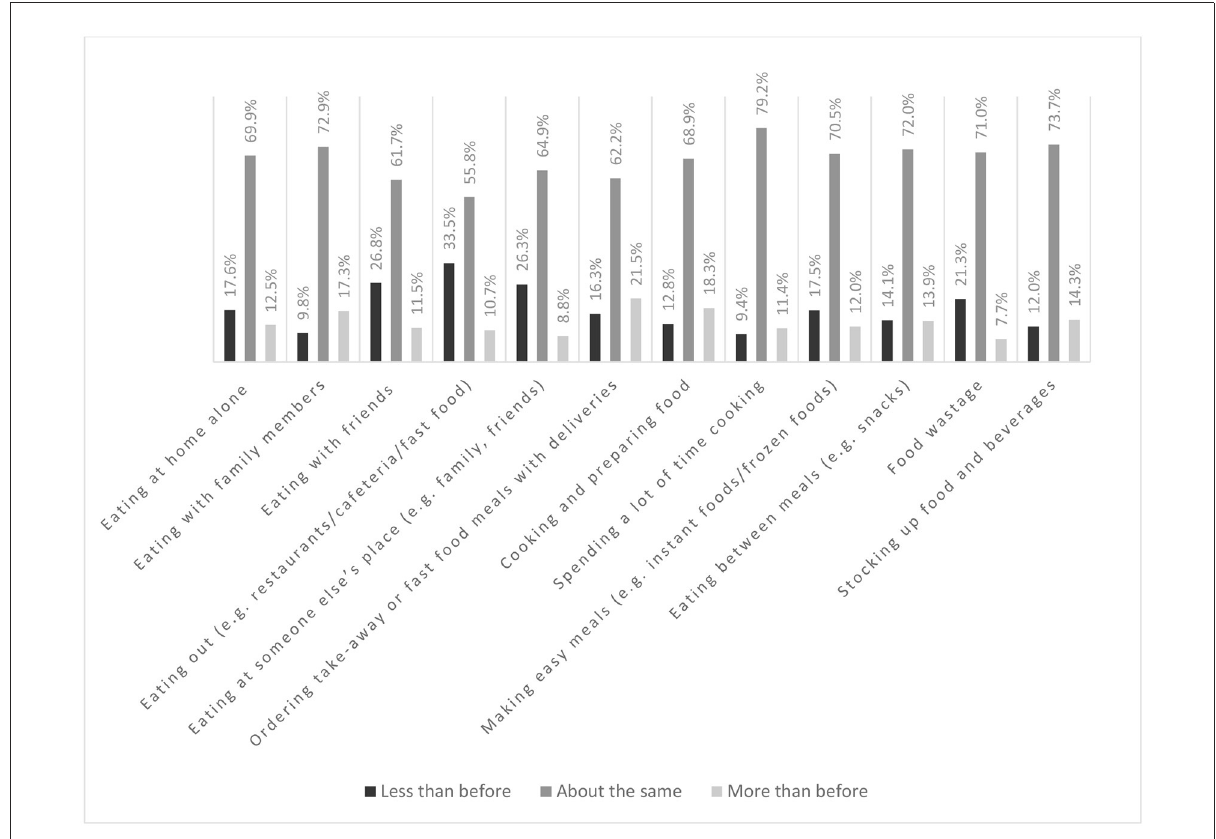
FIGURE3 Changes in food-related behaviors after the availability of the COVID-19